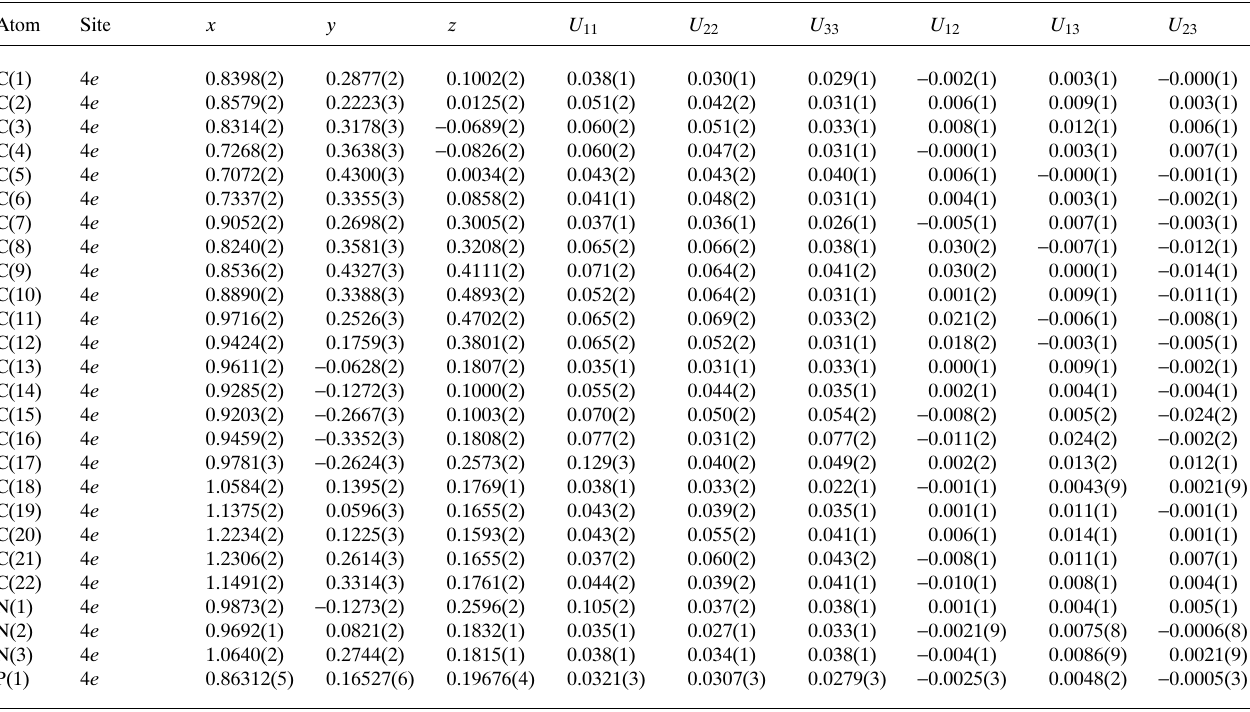
Table 3. Atomic coordinates and displacement parameters (in Å 2 )